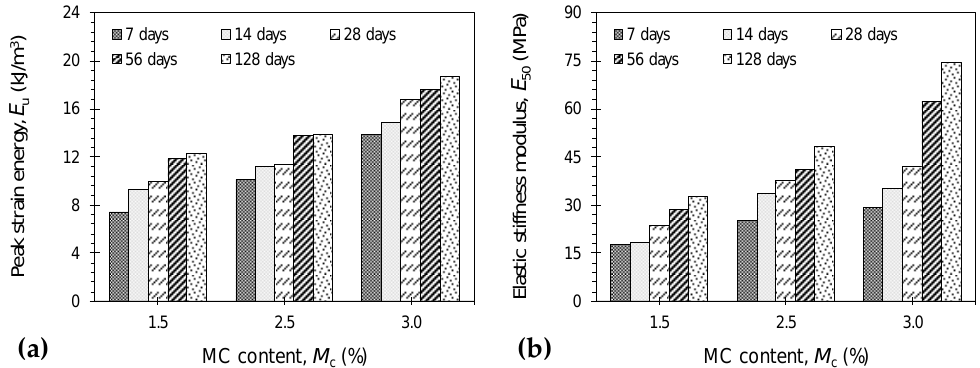
Figure 2. Variations of ( a ) peak strain energy E u and ( b ) elastic stiffness modulus E 50 against MC content for the samples tested at various curing times (i.e., M x F y T z where x = {1.5, 2.5, 3.0}, y = {0} and z = {7, 14, 28, 56, 128}).